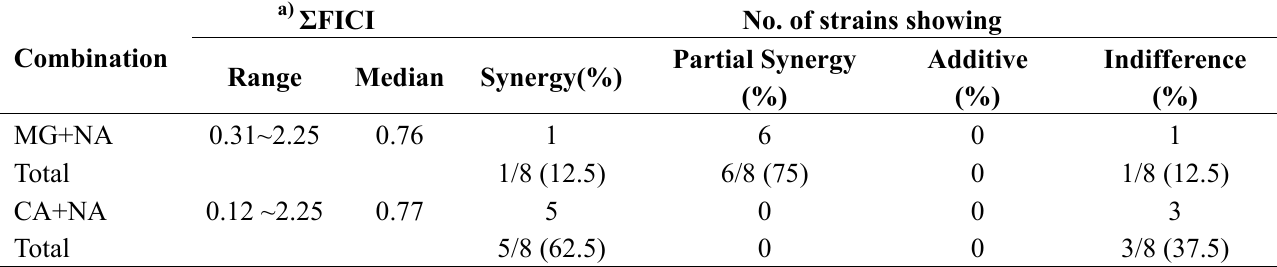
Table 4. Σ FIC values and number of nalidixic acid-resistant pathogenic bacteria showing synergy, partial synergy or indifference with methyl gallate (MG) + nalidixic acid (NA) and carvacrol (CA) + nalidixic acid (NA)